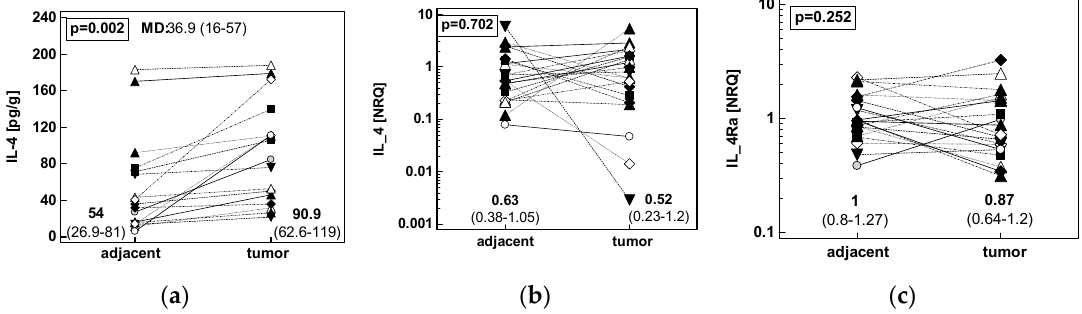
Figure 1. Patients’-matched analysis of tumor and tumor-adjacent tissue expression of: ( a ) IL-4 protein in CRC ( n = 17); ( b ) IL4 mRNA in CRC ( n = 21); ( c ) IL4Ra mRNA in CRC ( n = 21). Data were analyzed as logs using t -test for paired samples and presented as geometric means with 95% confidence interval ( CI ). Mean di ff erence in protein concentration (MD) between groups is accompanied by 95% CI . Transcriptomic data are presented as normalized relative quantities (NRQ). CRC, colorectal cancer; ESCC, esophageal squamous cell carcinoma; GC, gastric